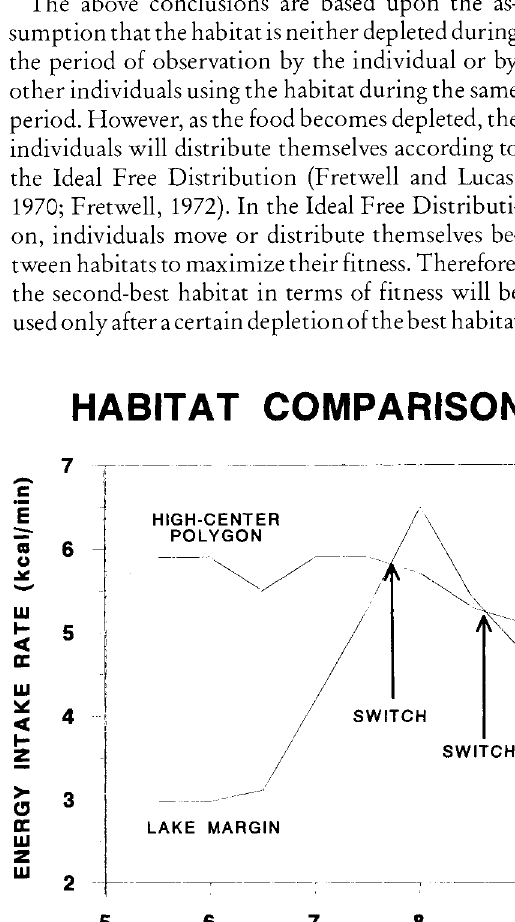
MONTH 3. The seasonal change in energy intake rate for cari Fig. bou/reindeer in two habitats is presented. The op timum switching between habitats based upon energy intake rate is depicted. The relationship is adapted from White's (1983) representation of dry matter intake, and the linear programming diet model's conversion of dry matter intake into ener gy intake per